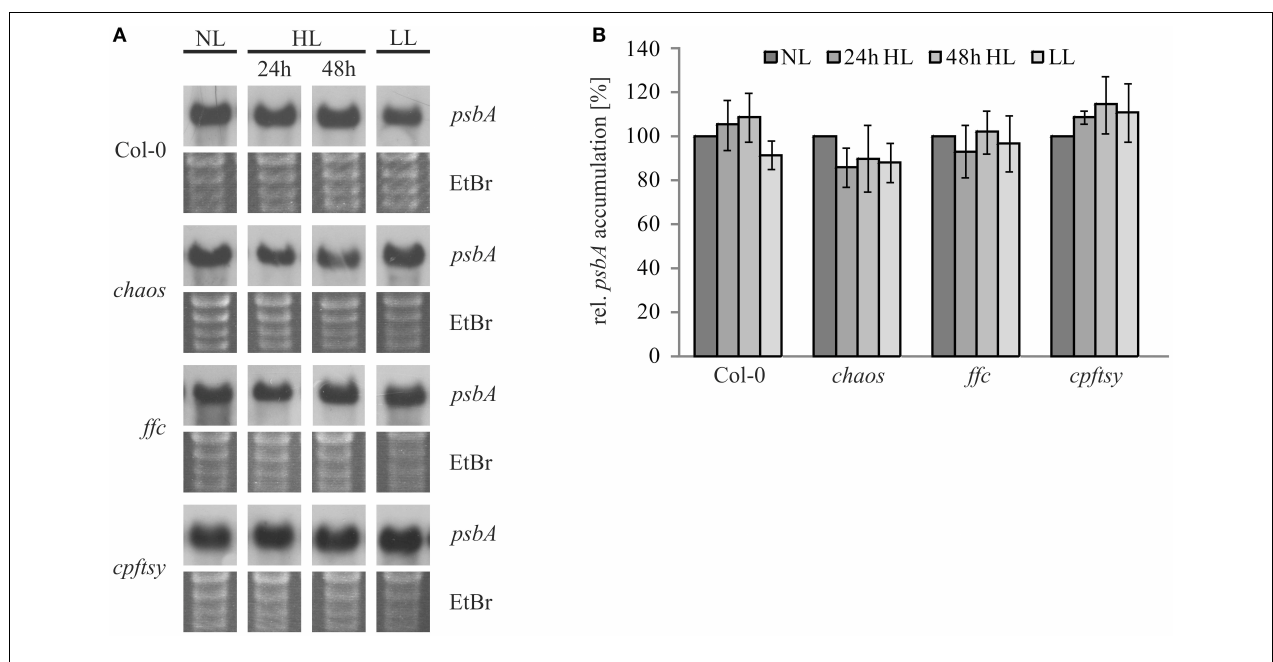
FIGURE 5 | PsbA transcript levels during high light stress treatment and a recovery phase. (A) Total RNA was isolated from fully expanded leaves of wild type and cpSRP mutant plants after growth at normal light (120 µ mol photons m − 2 s − 1 ), 24h of high light (1000 µ mol photons m − 2 s − 1 ), 48h of high light and a subsequent regeneration for 48h at low light (50 µ mol photons m − 2